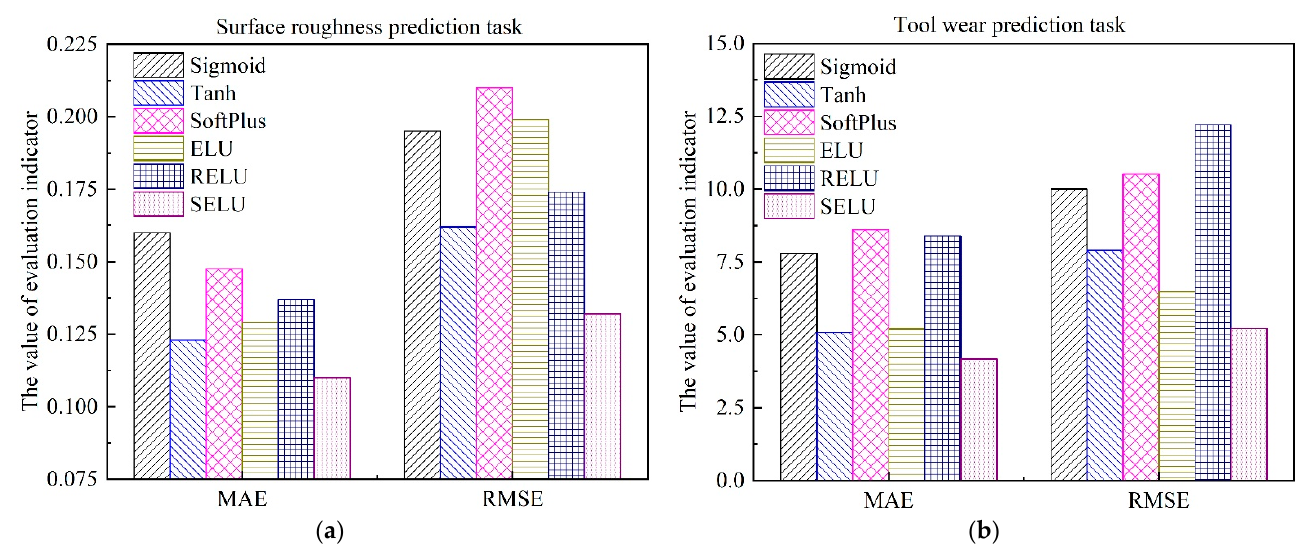
Figure 12. Performance comparison of different activation functions of SDAE, and the activation function of SCAE is RELU. ( a ) Surface roughness; ( b ) Tool wear.